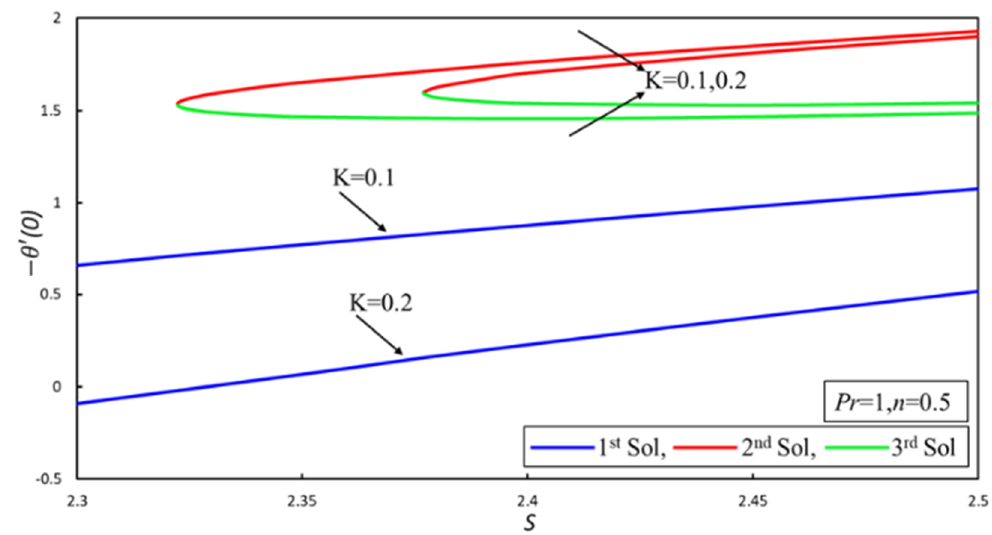
Figure 6. Variation of − θ (cid:48) ( 0 ) for di ff erent fixed values of K with suction parameter S .